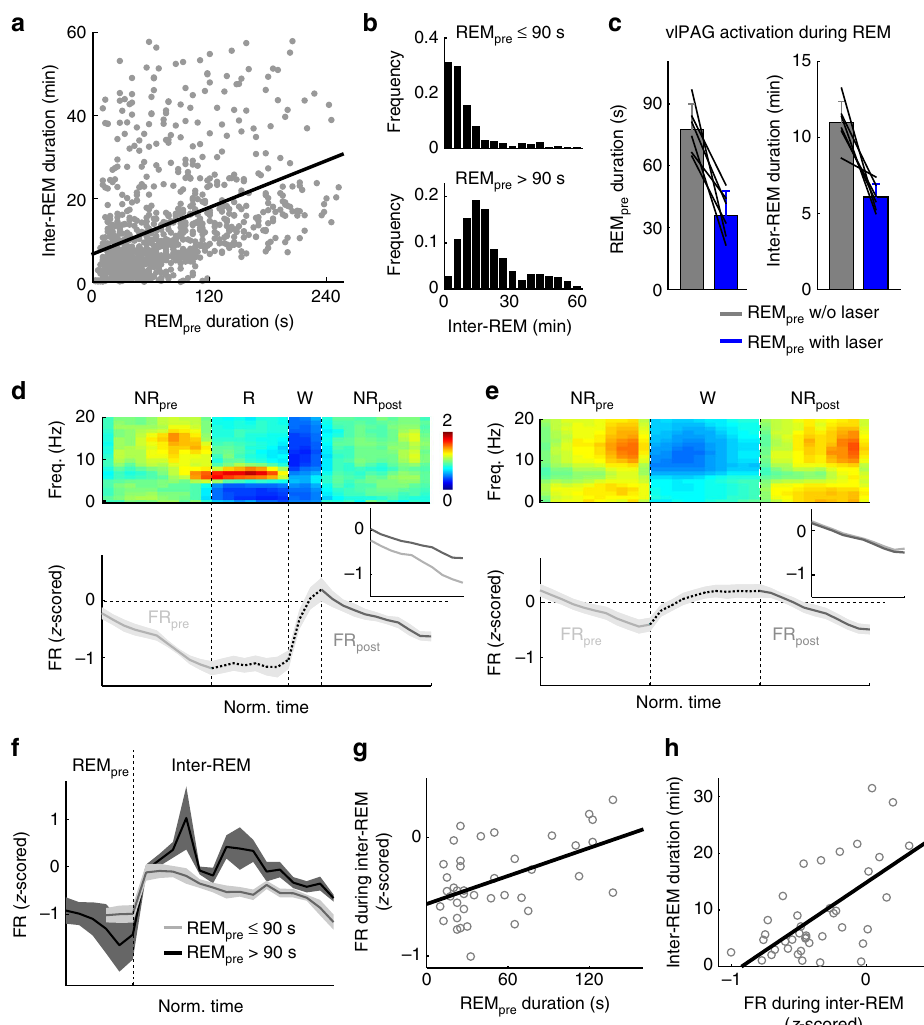
Fig. 6 Homeostatic modulation of REM sleep and REM-off neuron activity. a Correlation between REM episode duration and subsequent inter-REM interval. Each dot represents a single episode ( n = 972 episodes from 27 mice). Line, linear fi t ( R = 0.39, P = 6.8 × 10 − 36 , T (970) = 13.03). b Distribution of inter-REM interval following short ( ≤ 90 s) and long ( > 90 s) REM episodes. The two distributions are signi fi cantly different ( P = 2.8 × 10 − 48 , z = −